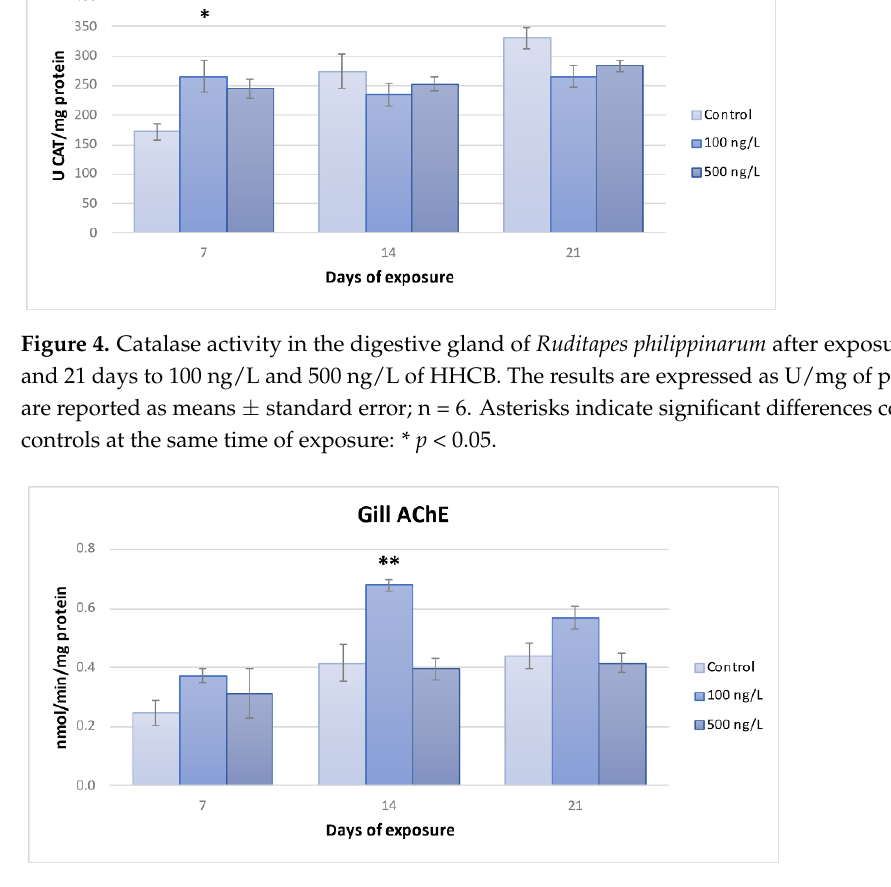
Figure 4. Catalase activity in the digestive gland of Ruditapes philippinarum after exposure for 7, 14 and 21 days to 100 ng/L and 500 ng/L of HHCB. The results are expressed as U/mg of proteins and are reported as means ± standard error; n = 6. Asterisks indicate significant differences compared to controls at the same time of exposure: * p < 0.05.